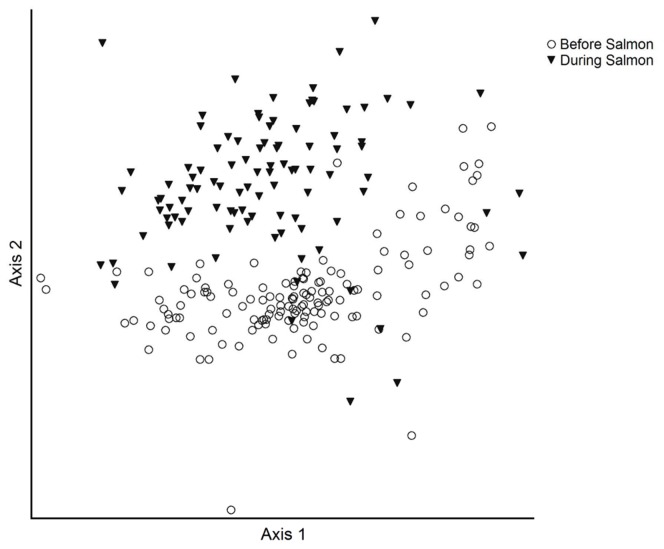
Macroinvertebrate communities before and during spawning.Non-Metric Multi-Dimensional Scaling ordination showing the separation of invertebrate community structure before and during the salmon run. A total of 65% of the variation in macroinvertebrate community structure was explained by: 1st axis  = 36% and 2nd  = 29%.